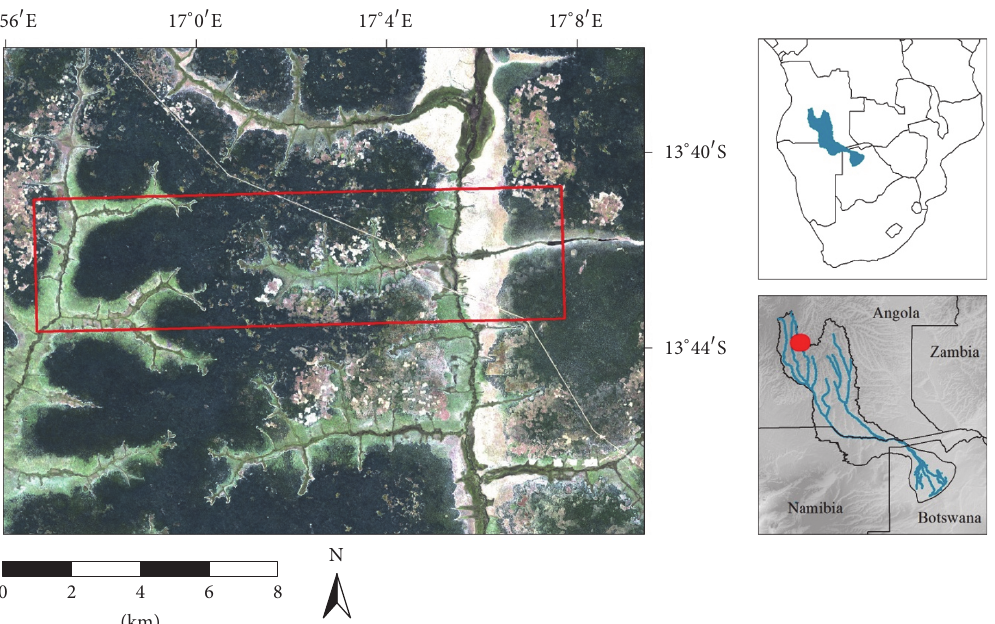
Figure 1: Location of the Okavango basin in southern Africa and the study site in Cusseque (denoted in red). The Okavango basin as shown here follows the definition of “The Future Okavango Project” http://www.future-okavango.org